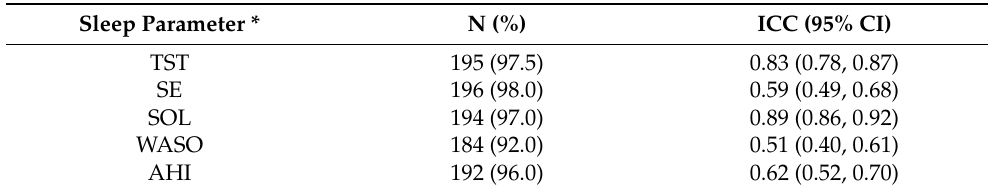
Table 1. The agreement between two raters measured by inter class correlation (95% confidence intervals) on sleep notes.